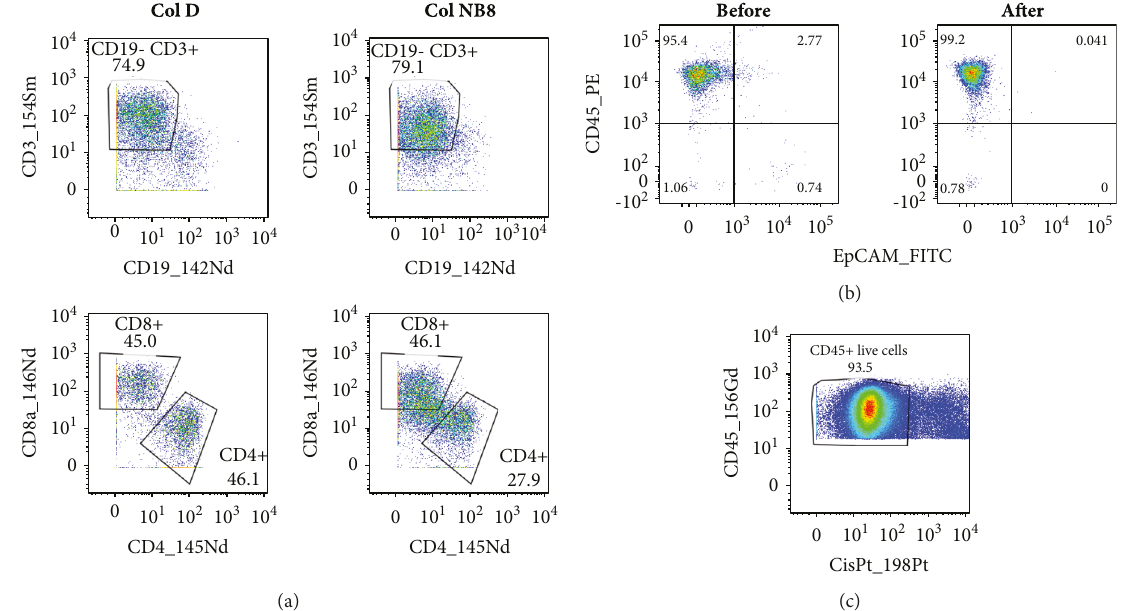
Figure 1: Sample preparation. (a) Tumor tissue was halved and treated with either Col D or Col NB8 together with DNase I using a gentleMACS Octo Dissociator and its prede fi ned programs. After lysis of erythrocytes, the single-cell suspensions were stained with the designed panel of antibodies. The same gates were applied to cell populations originated from the tissues treated with Col D or Col NB8. (b) Samples of cells prepared from tumors were labeled with fl uorescent anti-CD45 and anti-EpCAM antibodies before and after magnetic removal of epithelial cells. (c) Cells isolated from the tumor sample were stained with cisplatin for viability detection. The experiments were repeated with similar